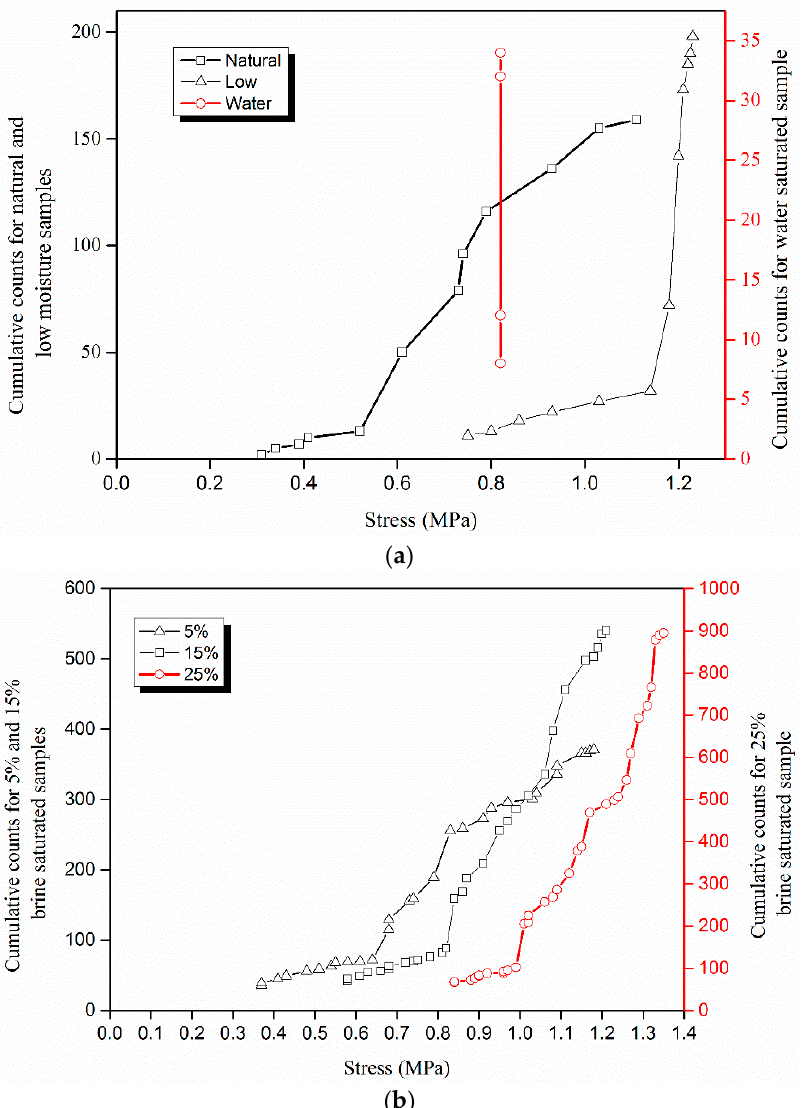
Figure 7. ( a ) Comparison of cumulative number of acoustic emission (AE) counts for different moisture content samples; ( b ) Comparison of cumulative number of AE counts for different brine content samples. Table 7. Stress threshold values of different moisture content samples.